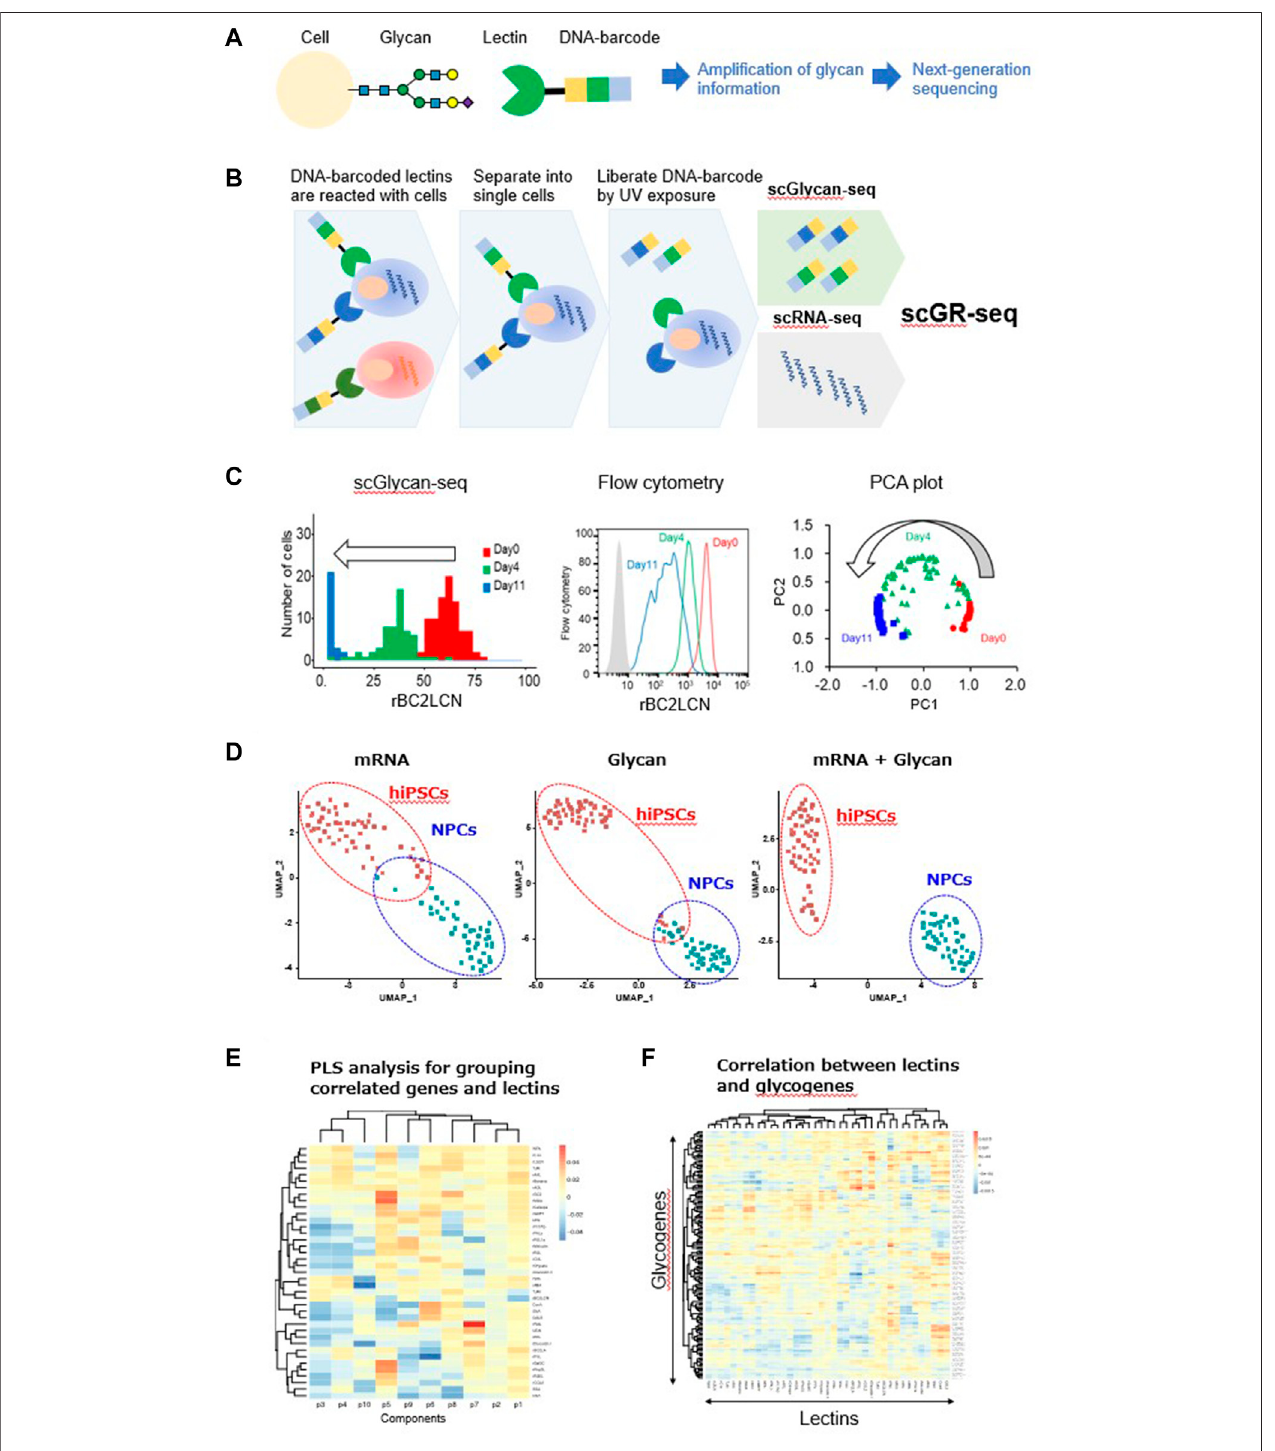
FIGURE 1 | Single-cell glycan and RNA sequencing (scGR-seq). (A) Principle of converting glycan information into gene information by DNA-barcoded lectins. (B) Schematic experimental work fl ow of scGR-seq. (C) hiPSCs after 0- ( red ), 4- ( green ), and 11-day differentiation ( blue ) into neural progenitor cells were analyzed by scGlycan-seq (left panel), fl ow cytometry (middle panel), and principal component analysis (right panel). (D) Dimensional reduction and clustering. UMAP visualization basedononlythescRNA-seqdata(leftpanel),onlythescGlycan-seq(middlepanel),bothscRNA-seqandscGlycan-seq(scGR-seq,rightpanel)dataofhiPSCs(n = 53, red ), and NPCs (n = 43, green ). (E) PLS regression. A heatmap showing the association between each lectin and each component inferred by PLS regression. Rows represent lectins, and columns represent components. (F) Correlation between lectin signal and glycosyltransferase gene expression. A heatmap showing the association of glycogenes and lectins inferred by PLS regression. Rows represent genes, and columns represent lectins. Figures are reprinted from Minoshima et al. (2021) (Minoshima et al., 2021).